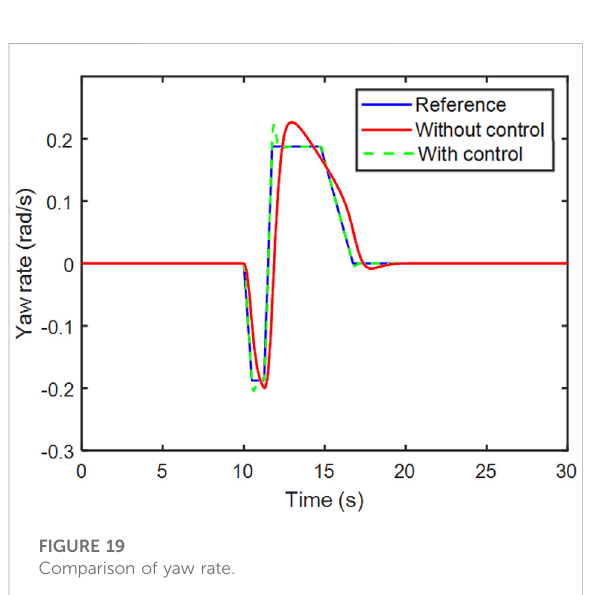
FIGURE 19 Comparison of yaw